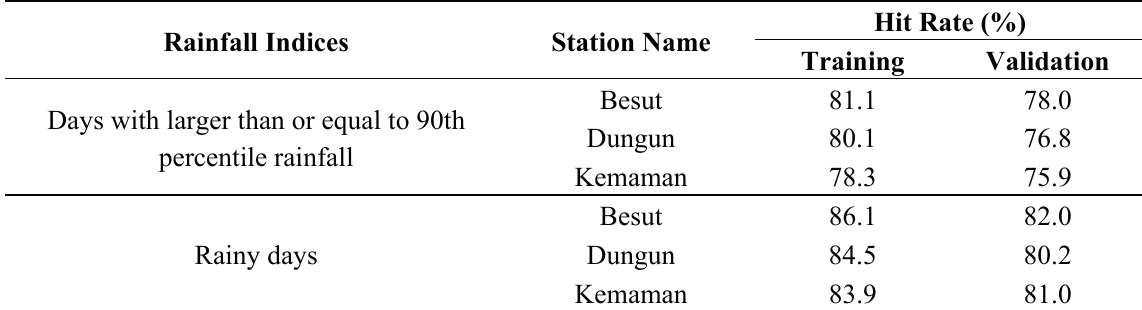
Table 4. Overall hit rates during training and validation of genetic programming (GP) models in downscaling rainfall indices.